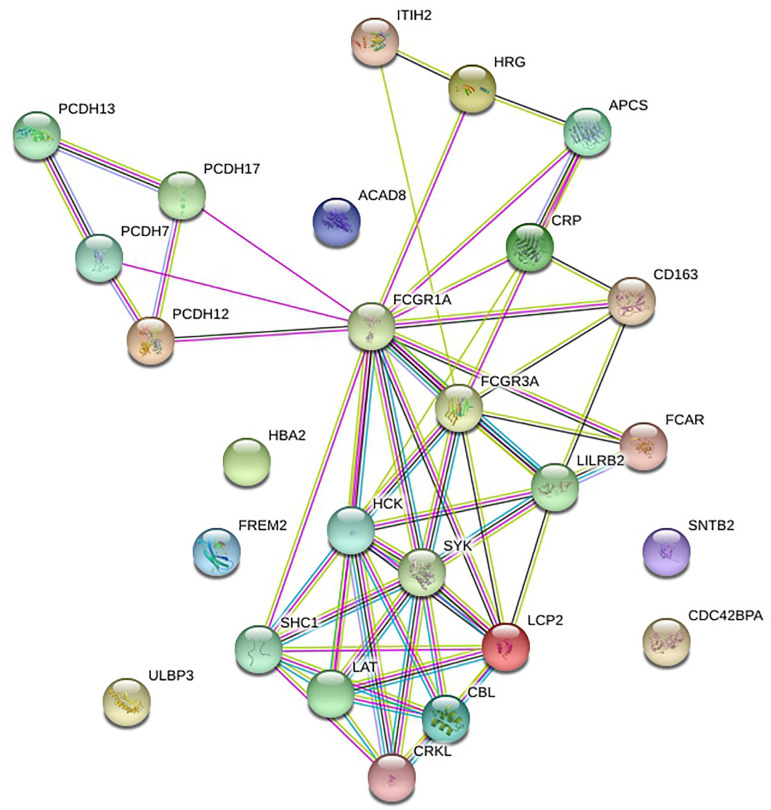
Protein–protein interaction network of FCGR1A.